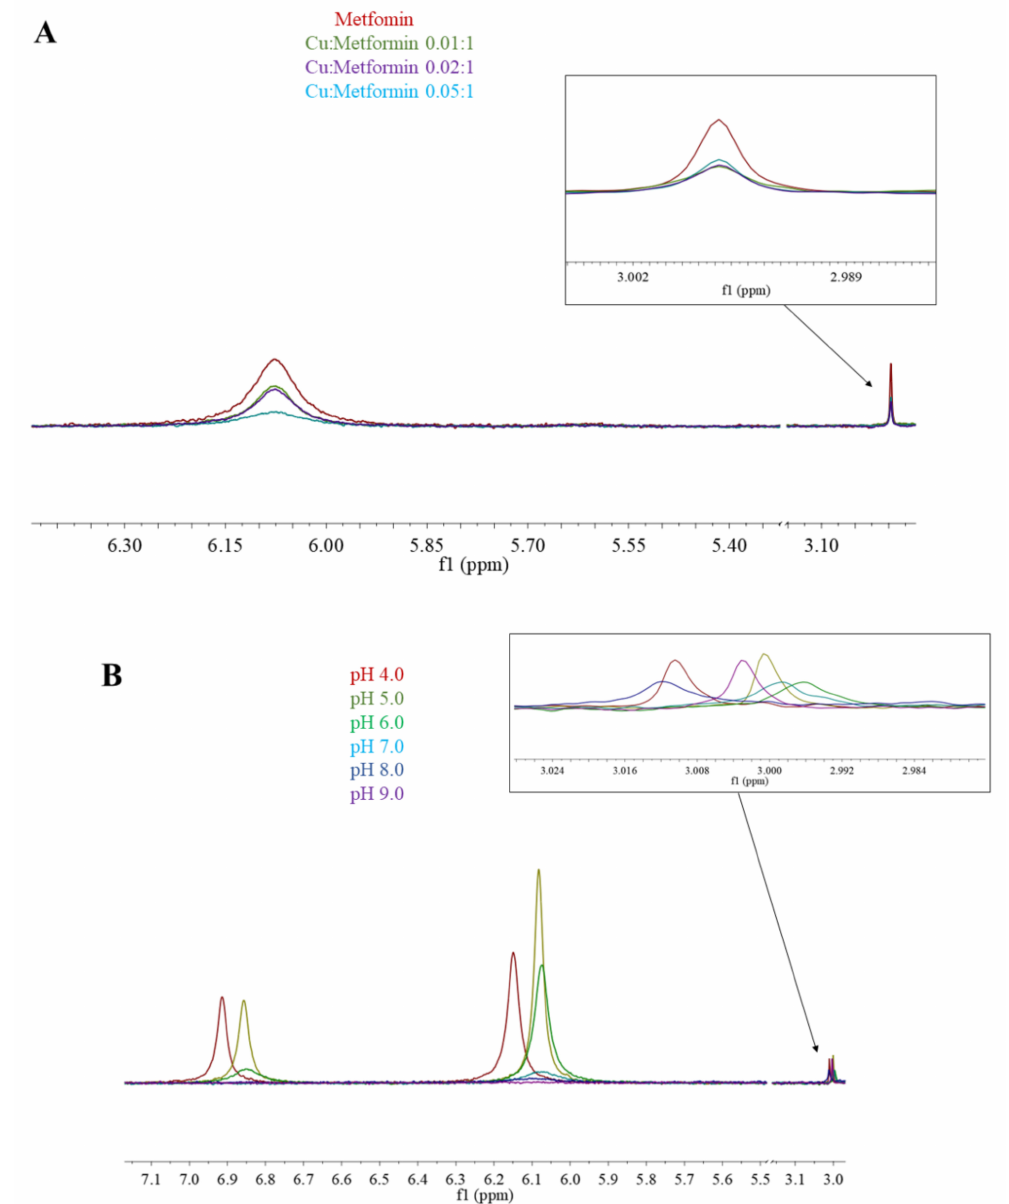
Figure 5. 1 H-NMR spectra of ( A ) Cu(II)/metformin titration; pH 7.4; ( B ) Cu(II)/metformin (0.05:1) pH